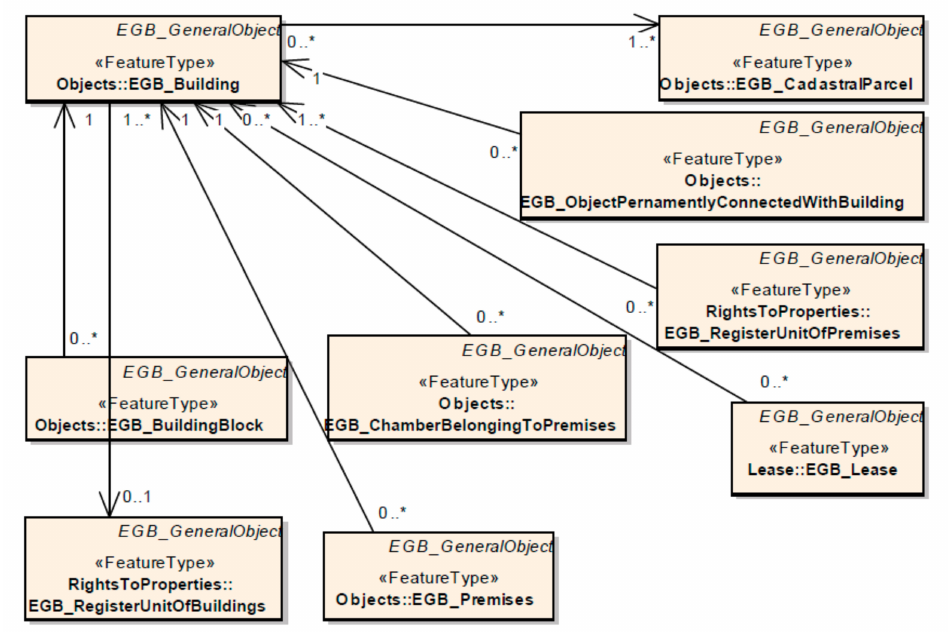
Figure 3. The relationships between ‘EGB_Building’ and other classes of the Polish cadastral